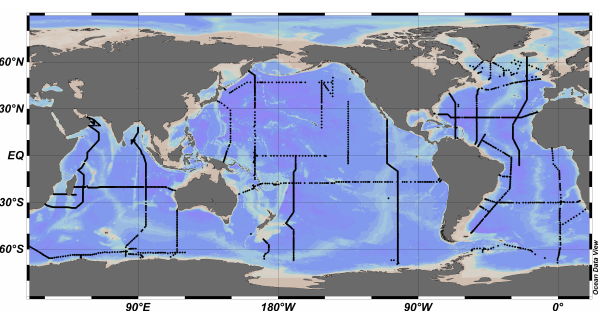
Fig. 5. Distribution of the T1 independent dataset.